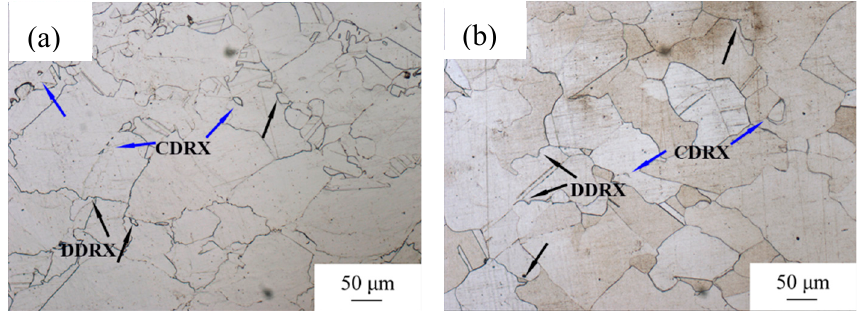
Figure 11. OM maps of Nb-contained 316LN compressed under strain 0.2 and at ( a ) 1200 °C, 1 s − 1 ( b ) 1200 °C, 0.01 s − 1 .